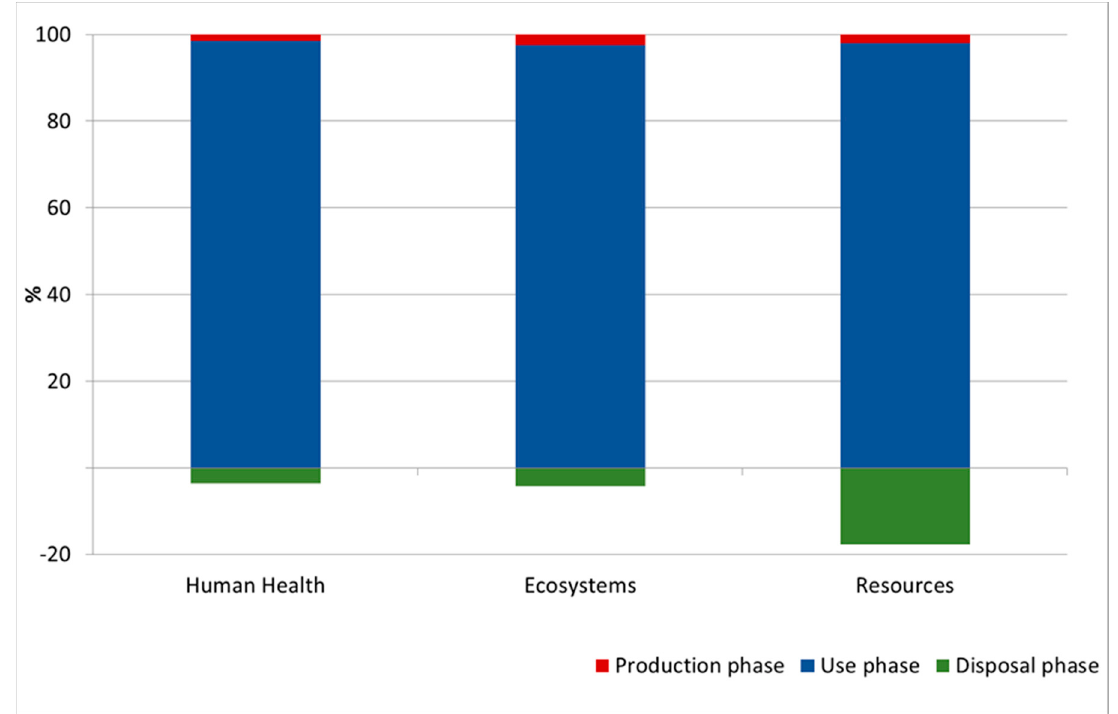
Figure 4. The LCA analysis of ReCiPe Endpoint (H) and the damage assessment in %.